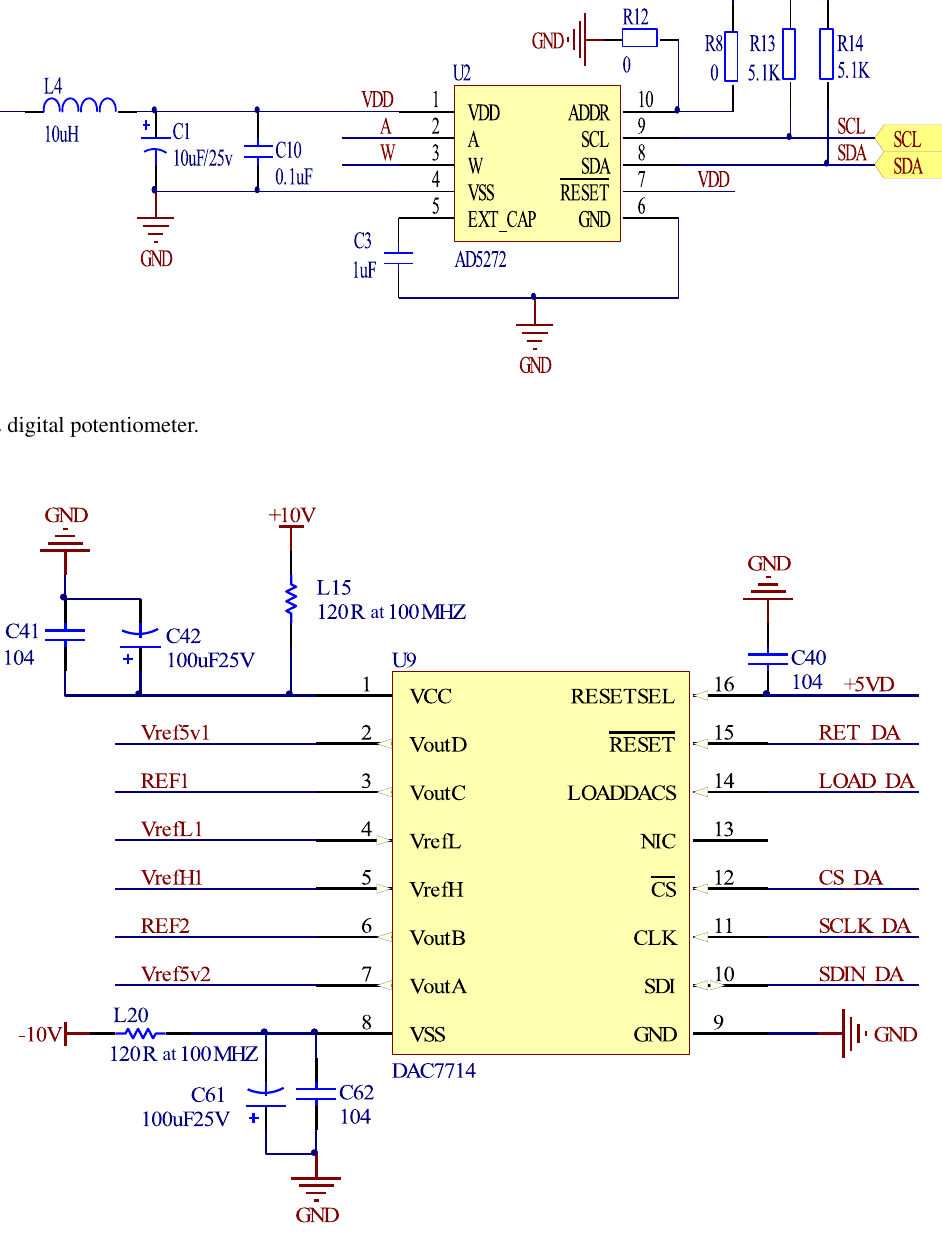
Figure 4. DAC7714 potential compensation and reference voltage